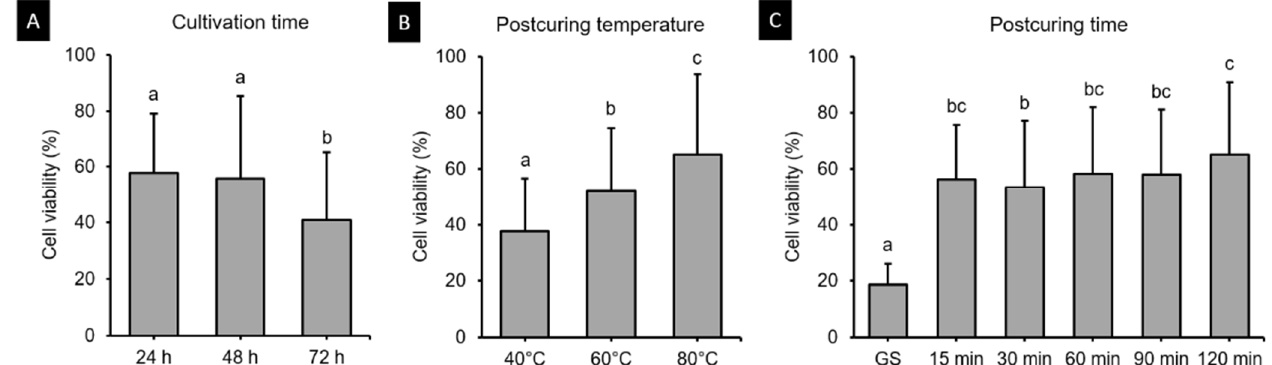
Figure 10. Results from three-way ANOVA. Cell viability data are presented according to ( A ) cultivation time, ( B ) postcuring temperature, and ( C ) postcuring time. Mean and standard-deviation values are shown. Different lowercase letters indicate a significant difference.